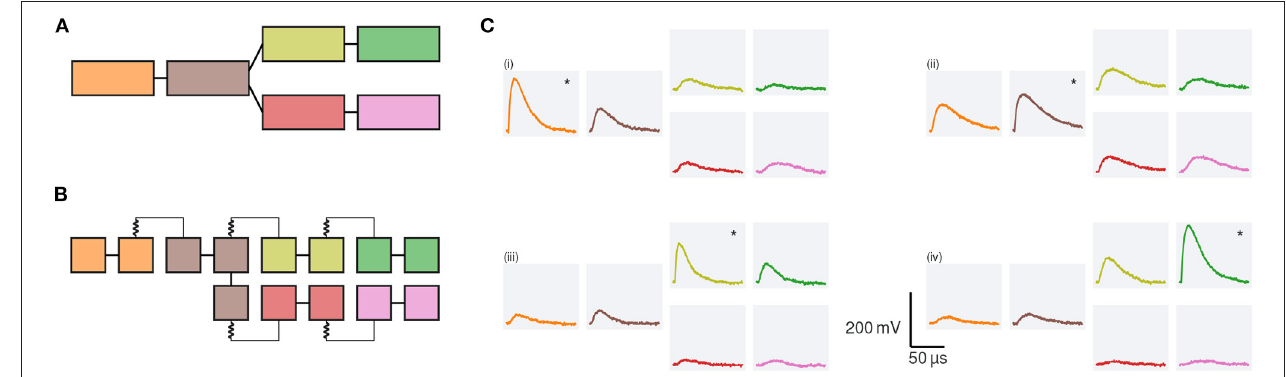
FIGURE 9 | Pulse propagation along a dendrite which branches into two sub-branches. (A) Each branch is modeled by two compartments (rectangles). Different compartments are connected via resistors (lines). (B) Hardware configuration: neuron circuits (squares) are arranged in two rows on BSS-2, compare Figure 1D . Each compartment is represented by at least two neuron circuits. Circuits which form a single compartment are directly connected via switches (straight lines); compartments are connected via resistors. For details see Kaiser et al. (2022). (C) Membrane responses to synaptic input: we inject synaptic input at four different compartments; the compartment at which the input is injected is marked by a *. The membrane traces of the different compartments are arranged as in (A) . For the top left quadrant (i) the input is injected in the first compartment and decreases in amplitude while it travels along the chain. The response in both branches is symmetric. A similar behavior can be observed when the input is injected in the second compartment, (ii). Due to the symmetry of the model, we only display membrane responses for synaptic input to the upper branch. When injecting the input in the first compartment of the upper branch, (iii), the input causes a noticeable depolarization within the same branch and the main branch but does not cause a strong response in the lower sister branch. All values are given in the hardware